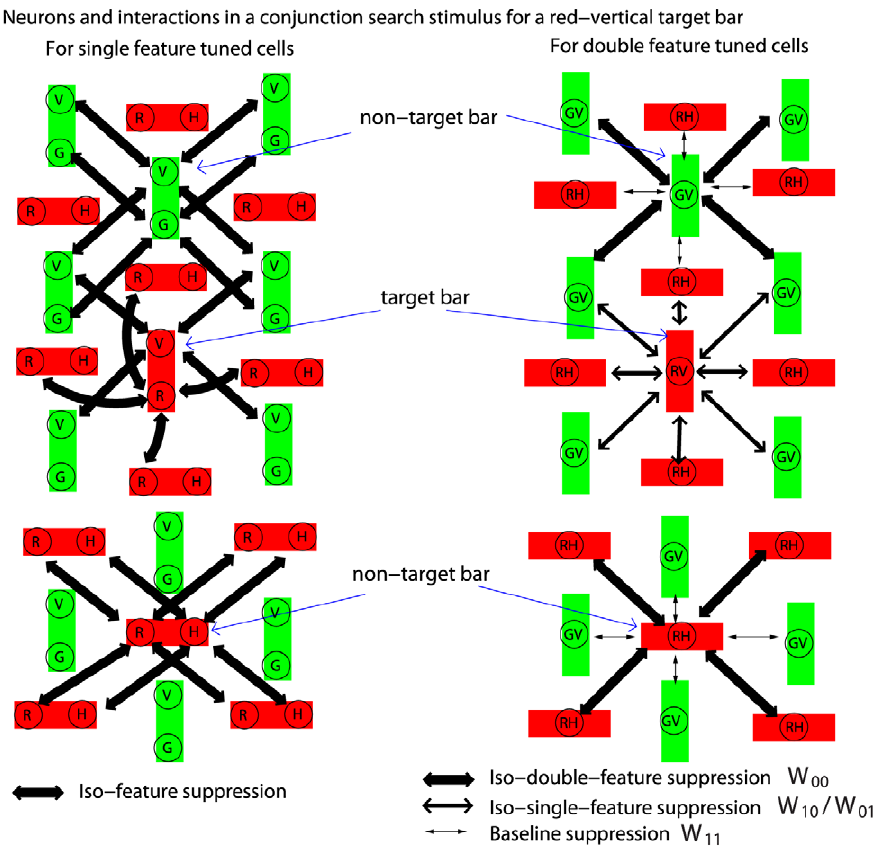
Figure 9. A schematic for neurons and their interactions in a conjunction search for a red-vertical target. Bars and neurons are similarly visualized as in Fig. 8. For clarity, interactions between single feature tuned neurons are shown separately (on the left) from those between conjunctive neurons. To avoid clutter, only interactions associated with neurons responding to the target bar and two of the non-target bars are shown, the baseline suppression on the single feature tuned cells and suppression between single feature tuned and conjunctive neurons are not shown. Each single feature tuned neuron, regardless of its preferred feature and regardless of whether it is responding to the target, experiences iso- feature suppression from neurons responding to about half of the neighboring bars. Hence, single feature tuned neurons cannot distinguish the target by their response levels. The conjunctive neuron (‘RV’) responding to the target experiences iso-single-feature suppression ( W 01 or W 10 ) from other conjunctive neurons responding to all neighboring bars, whereas each conjunctive neuron responding to a non-target experiences iso-double- feature suppression ( W 00 ) from conjunctive neurons responding to only half of the neighboring bars. The target cannot be distinguished by a higher response (from the ‘RV’ neuron) if W 01 z W 10 * > W 00 z W 11 , or if this neuron’s response is weaker than the responses from the single feature tuned neurons.